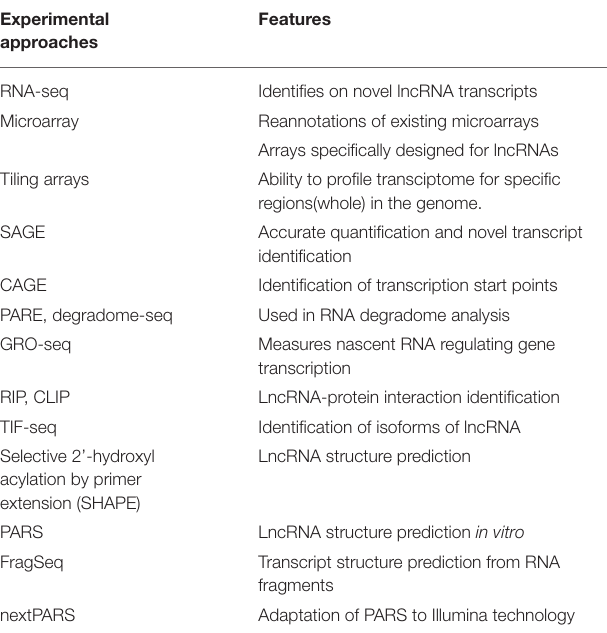
TABLE 2 | Experimental approaches in lncRNA